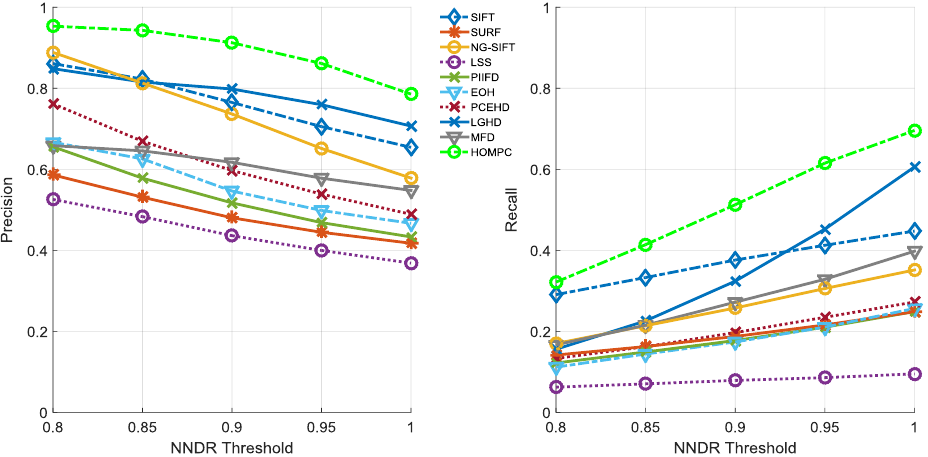
Figure 19. The average precision and recall curve results with different NNDR thresholds for all the descriptors. The HOMPC is our descriptor.